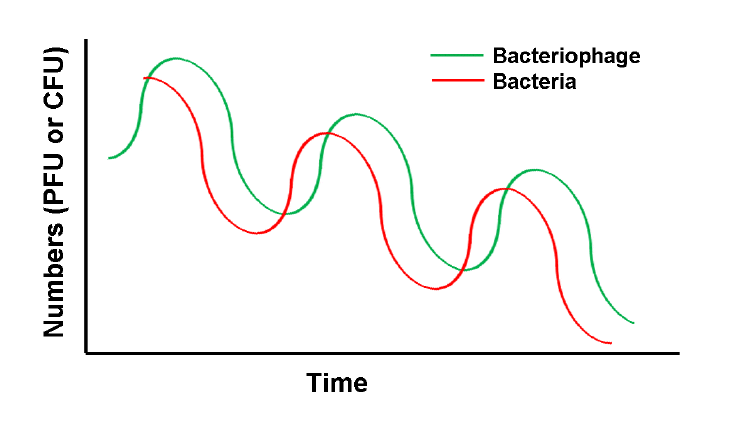
Figure 5. Predator-prey cycles as applied to bacteriophages